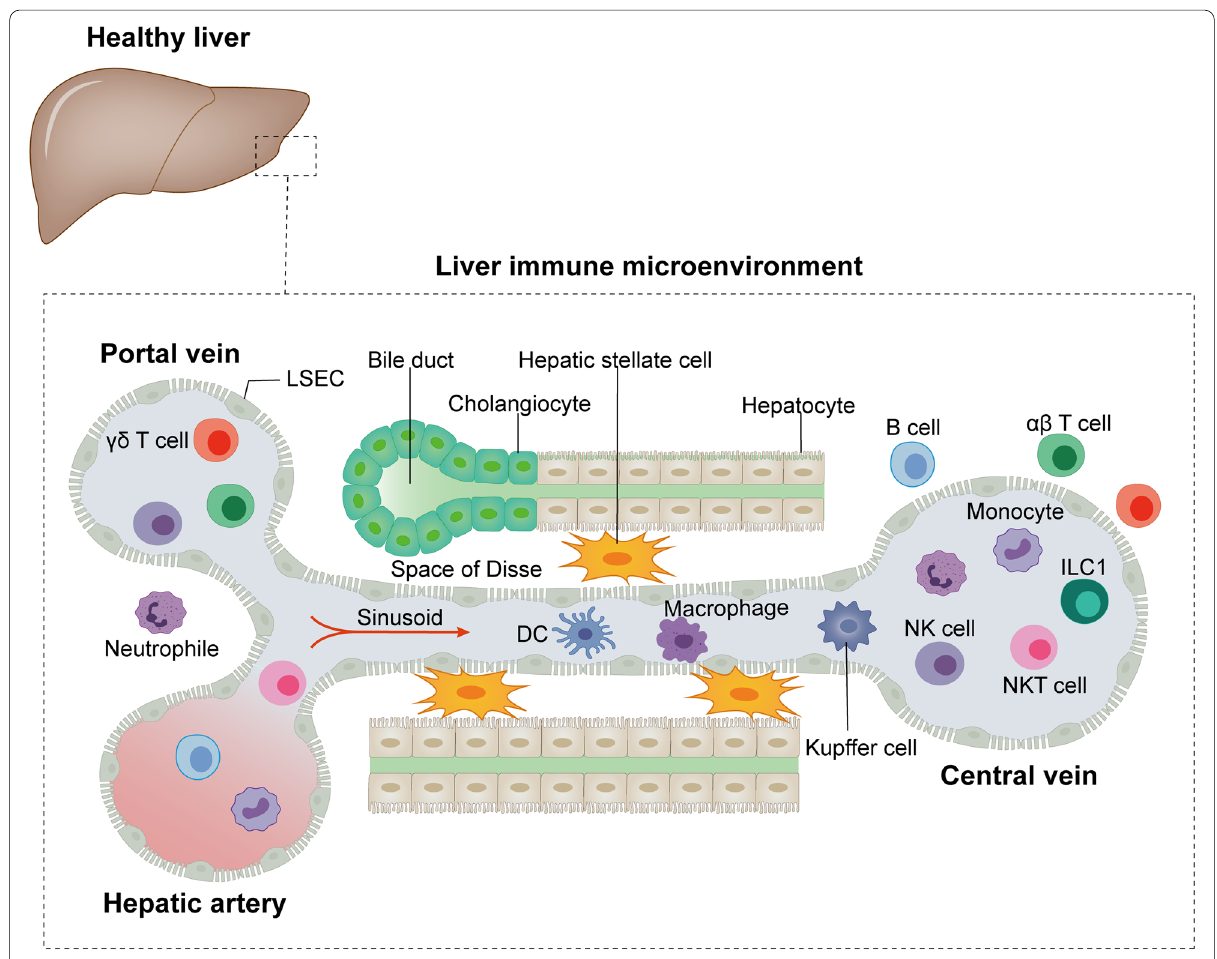
Fig. 1 Structure and cellular composition of the immune microenvironment of the healthy liver. The hepatic lobules are the basic units that make up the tissue of the liver. The central vein is located in the center of the hepatic lobules and is surrounded by hepatocytes arranged in a radial pattern. Blood flow from the portal vein and hepatic artery converges into the central vein through the hepatic sinusoids, which are composed of endothelial cells. Bile produced by hepatocytes is released into the intestine through bile ducts composed of bile duct cells. The hepatic artery, portal vein and bile ducts are located in the confluent area between the hepatic lobules. The cells in the liver consist of resident immune cells and immune cells recruited from the circulation. The former includes Kupffer cells, DCs, LSECs, HSCs, and ILC1, etc.; the latter includes monocyte‑macrophages, neutrophile, NK cells, NKT cells, αβ T cells, γδ T cells and B cells and so on. These cells are important components of the hepatic immune microenvironment and play an important role in clearing foreign bodies, initiating a rapid and controlled immune response in the face of external infections, and maintaining tolerance to autoantigens and food